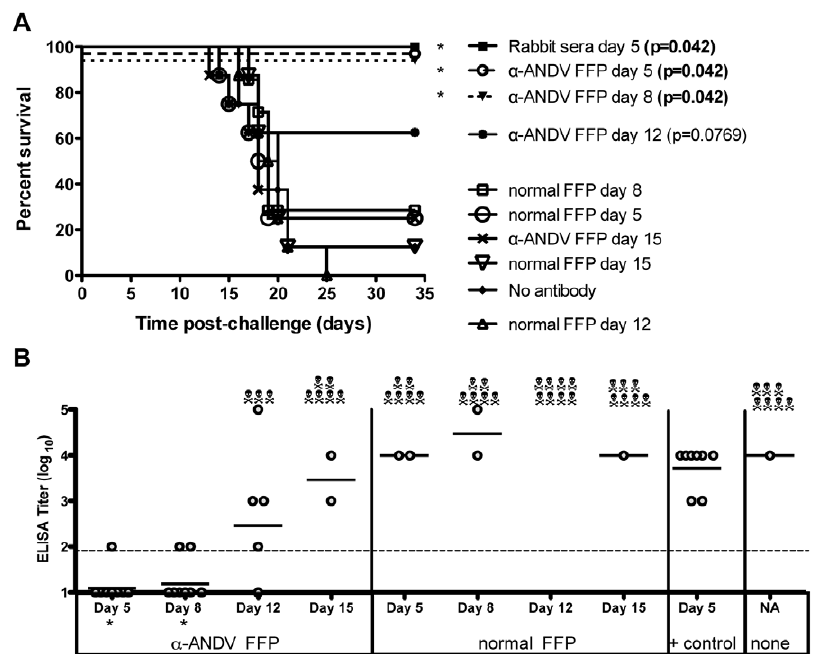
Figure 2. a -ANDV FFP passively transferred on days 5 and 8 protects hamsters from lethal disease and infection. A) Survival curve of hamsters challenged with 4,000 PFU i.n. of ANDV on day 0, then passively transferred with a -ANDV FFP (30,720 NAU/kg) on days 5, 8, 12 or 15 postinfection. Rabbit sera (administered at 1,920 NAU/kg) were collected 102 days post DNA vaccination [16]. P-values were determined based on comparison to normal serum on matching day. B) a -N ELISA endpoint titers (log 10 ) were conducted with sera from surviving hamsters challenged with ANDV in A). GMT for each group are shown. * indicates results are statistically significant when compared to rabbit sera positive control.